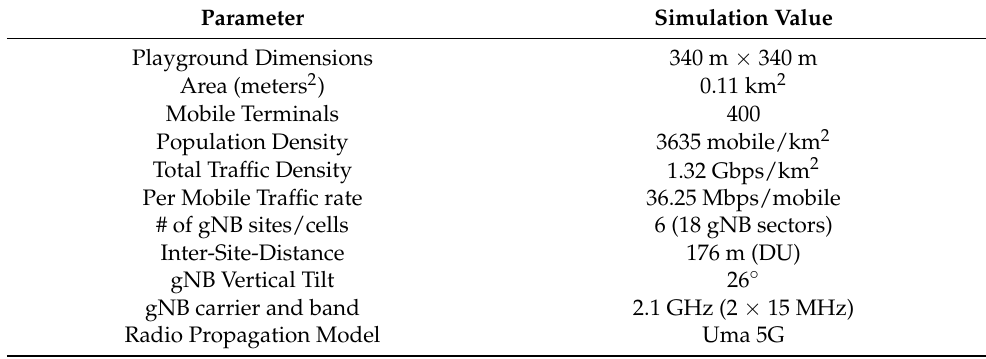
sector antennas Table 2. Standard traffic demand parameters were selected following the simulation scenarios used in existing 5G benchmarking studies. Table 2. Simulation scenario parameters.